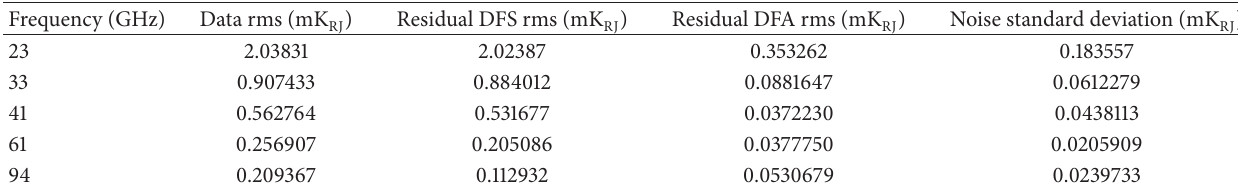
Table 5: Rms of the WMAP data and of the residuals after subtraction of the dust, free-free, and standard synchrotron model and of the dust, free-free, and anomalous emission model compared to the standard deviation of the noise.